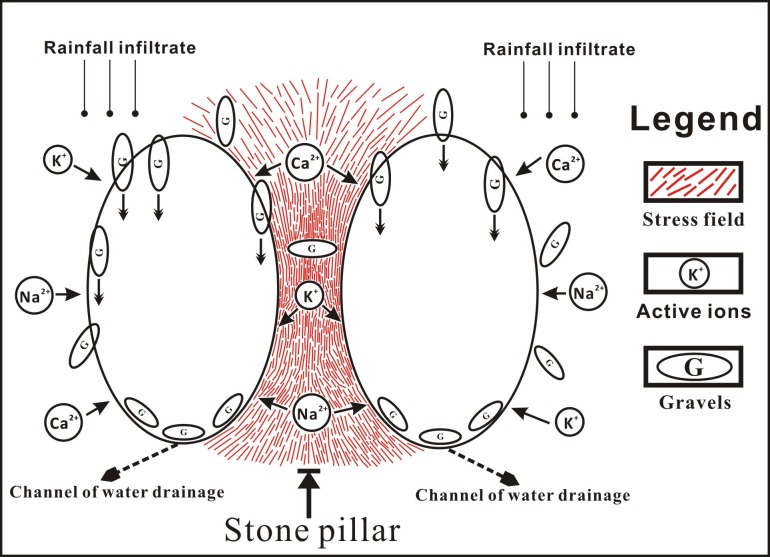
Sketch of the stress field distribution around the pillar in Hudiedong Cave (denser red lines indicate a higher stress magnitude).